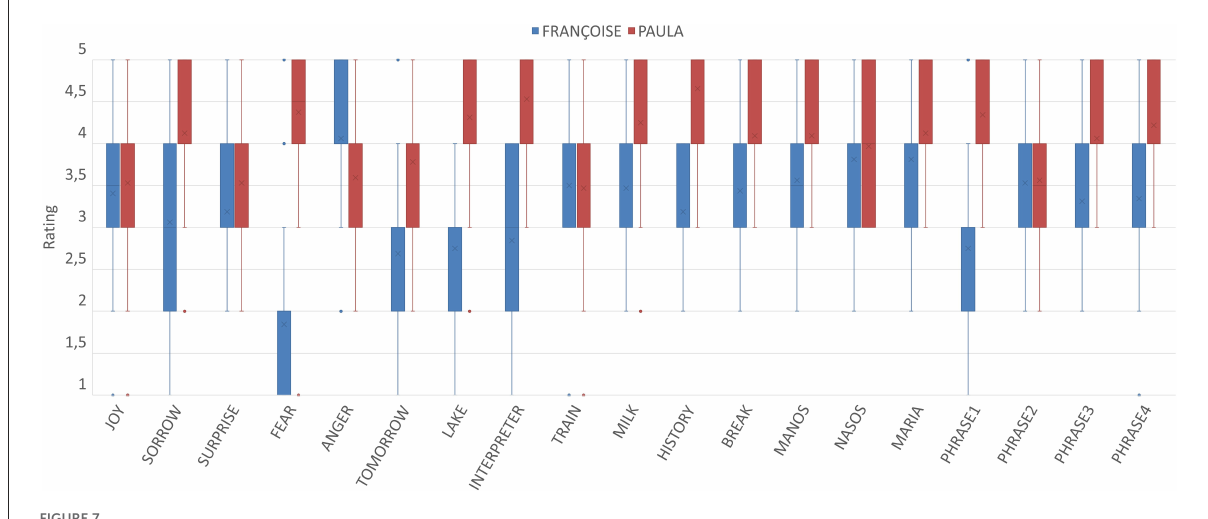
FIGURE7 Central tendency and spread of ratings per signing occurrence for both